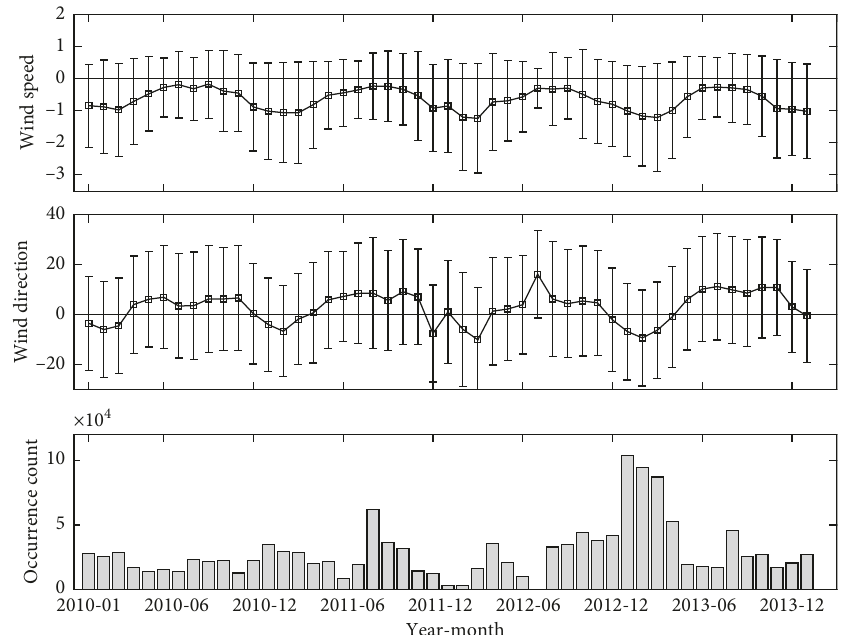
Figure 8: Statistical parameters of difference between OSCATand ASCATwind vectors at different months from January 2010 to February